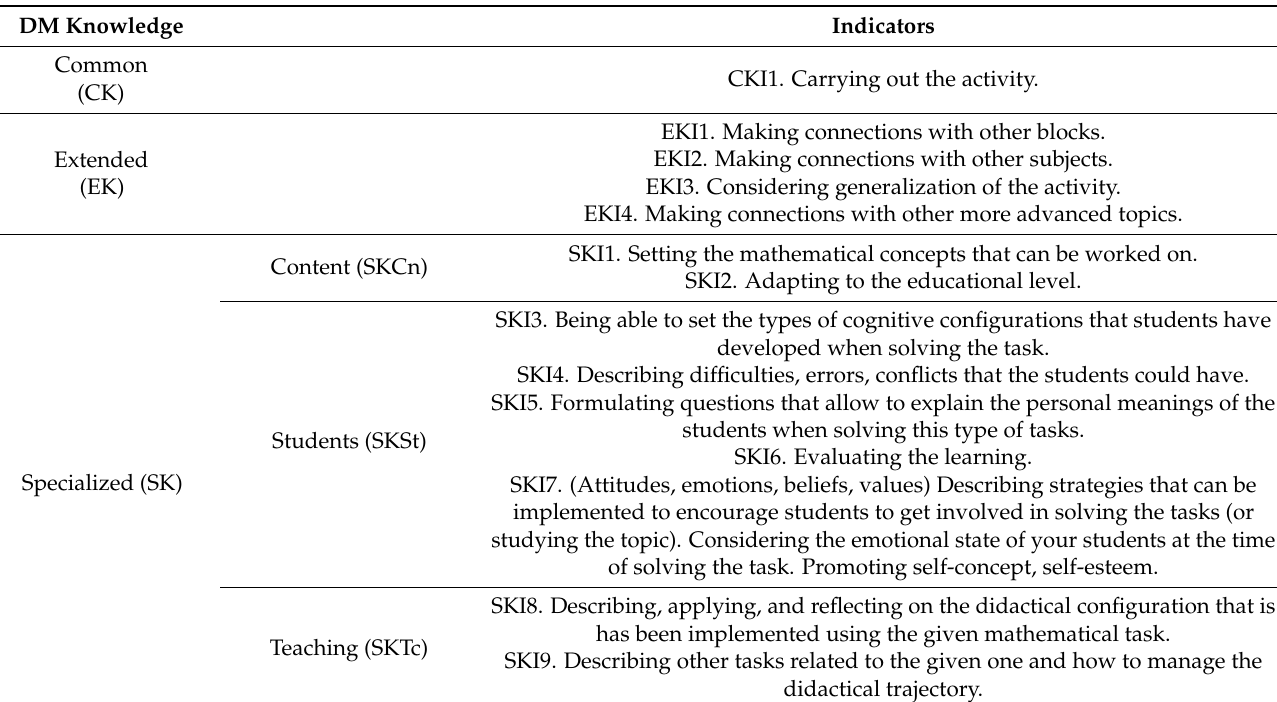
Table 1. Indicators of the DMK